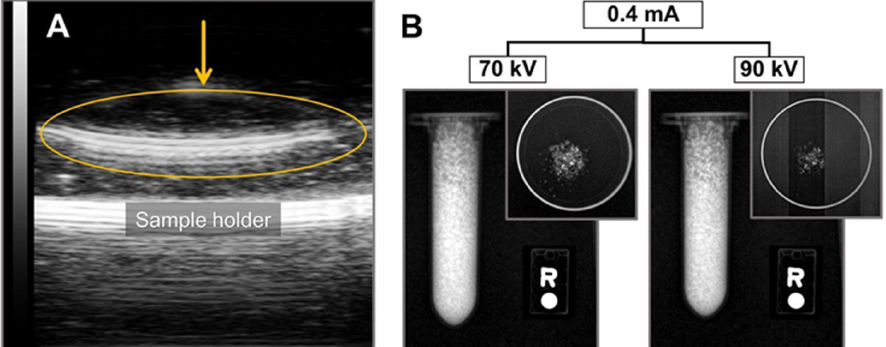
Figure 7. ( A ) Ultrasound imaging showing part -CaF 2 suspended in water (orange arrow). ( B ) X-ray image showing a 2 mL Eppendorf tube filled with part -CaF 2 and a top view of powder dispersed into a petri dish subjected to different potential and the same current intensity.